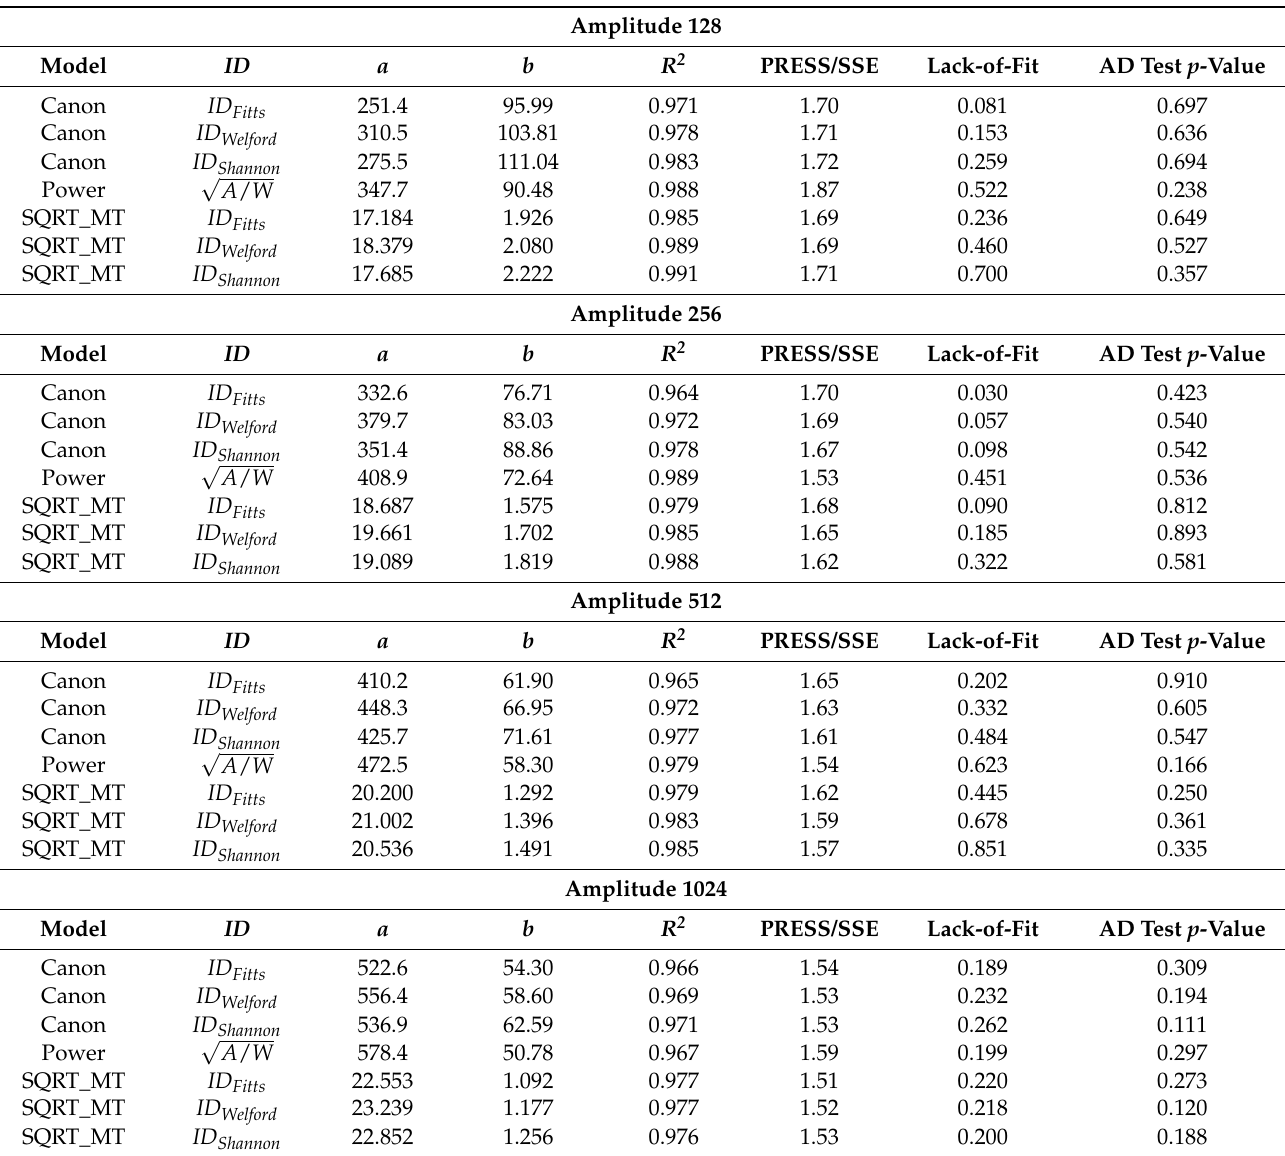
Table 10. Regression analysis with the amplitudes separated; only one failed the test of normality (Canon ID Fitts